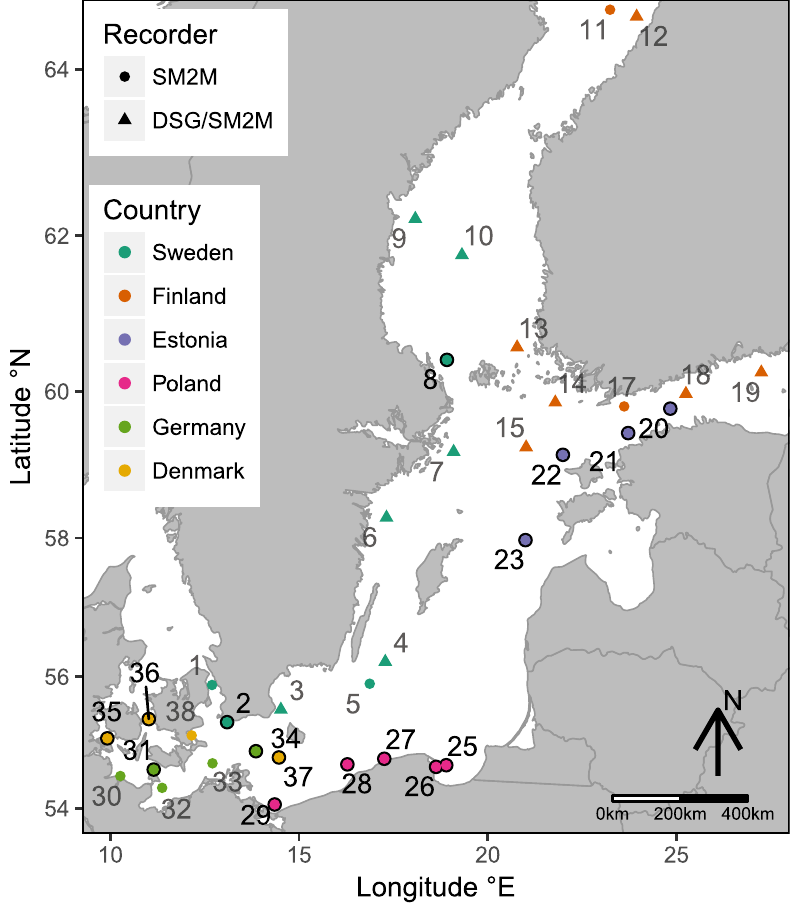
Figure 1. Underwater sound monitoring locations of the BIAS-project. The locations where SM2M marine submersible recorder was used throughout the sound monitoring are depicted with a circular marker and locations with alternate deployments of the DSG Ocean recorder with triangular markers. More details on the measurement equipment can be found in the methods section of this paper. The numbers of the monitoring locations analysed in this paper are highlighted with a darker